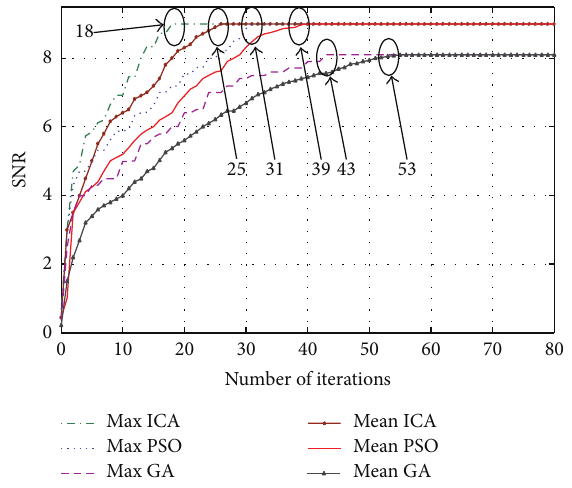
Figure 7: Convergence performance of the iterative